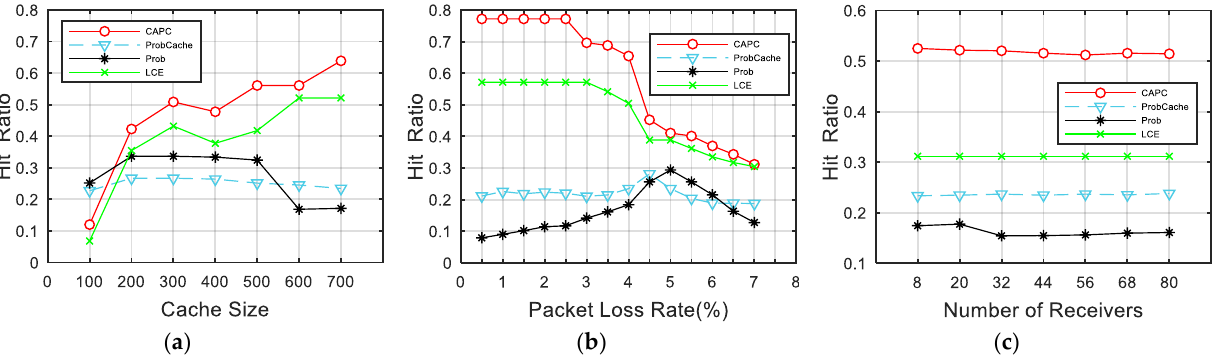
Figure 8. The comparison of average hit ratio. ( a ) The comparison of average hit ratio under different cache sizes; ( b ) the comparison of average hit ratio under different packet loss rates; ( c ) the comparison of average hit ratio under different numbers of receivers.